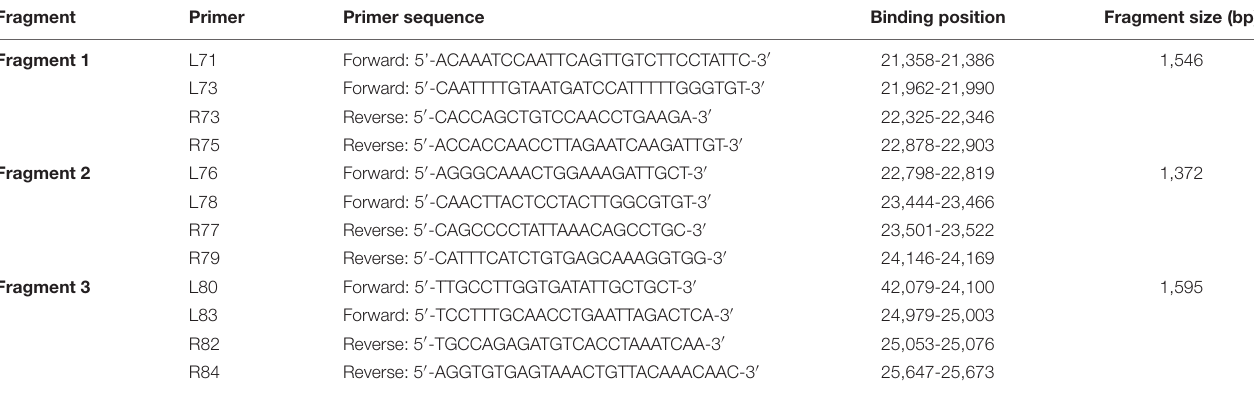
TABLE 1 | A list of primer sequences used for RT-PCR analysis and sanger sequencing of spike protein. Fragment Primer Primer sequence Binding position Fragment size (bp)